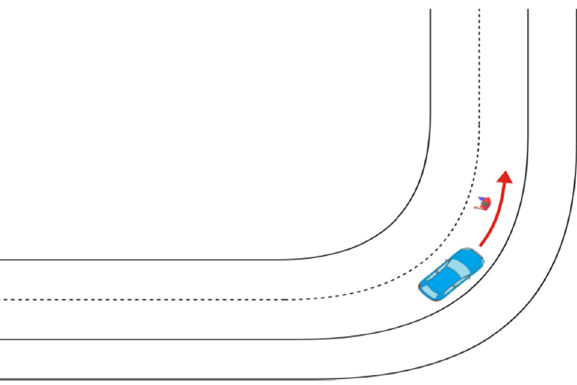
Figure 11: Research situation in test 3. Source: “ authors ” own research.